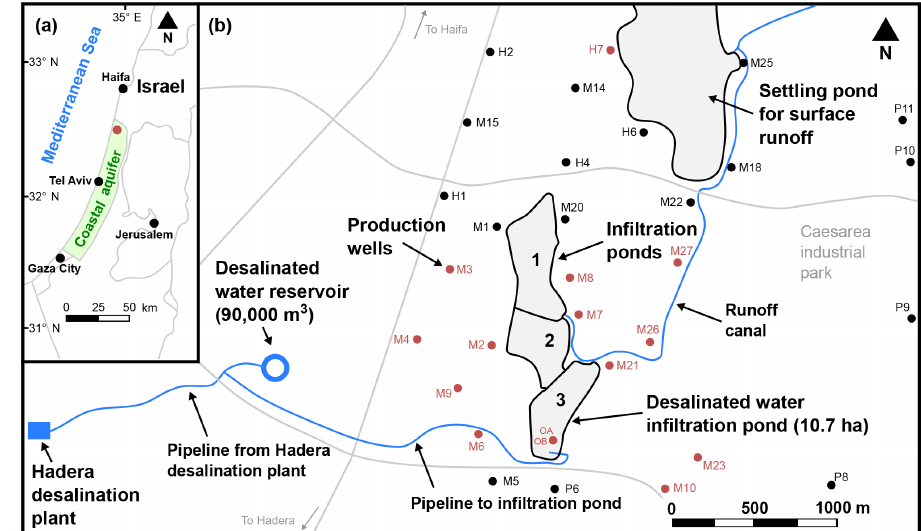
Figure 1. Map of the study area. (a) Location of the Israeli coastal aquifer and the Menashe MAR site (red circle). (b) The Menashe MAR site. A surplus of desalinated seawater is delivered from the Hadera SWRO desalination plant (lower left) to the southern infiltration basin (pond 3). The red dots represent wells that were sampled for water isotope